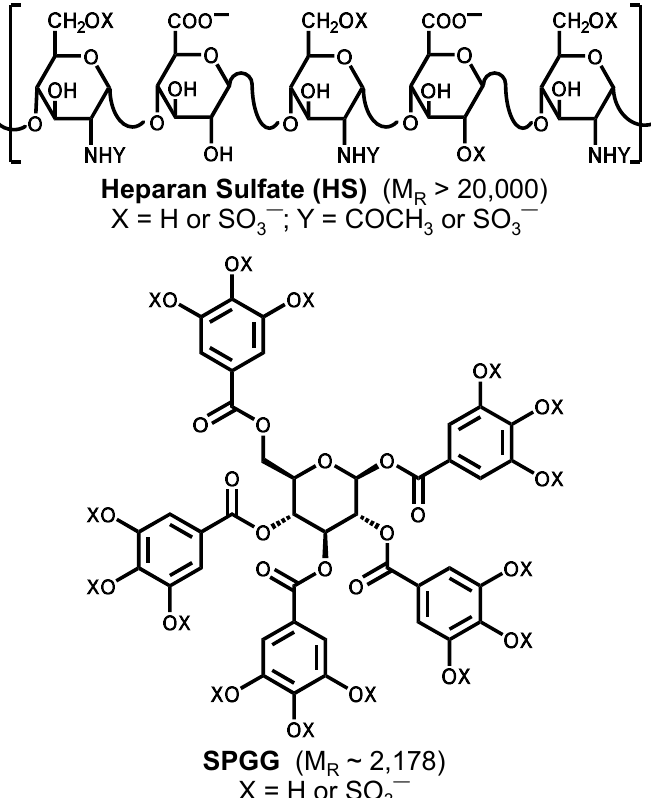
Figure 1. Heparan sulfate (HS) and sulfated pentagalloylglucoside (SPGG). Whereas HS is a linear polymer with an average molecular weight (Mr) of approximately 20,000, SPGG is a globular small molecule with Mr of 2178. HS is a biopolymer; in contrast SPGG is synthesized in 5 steps in excellent yields.